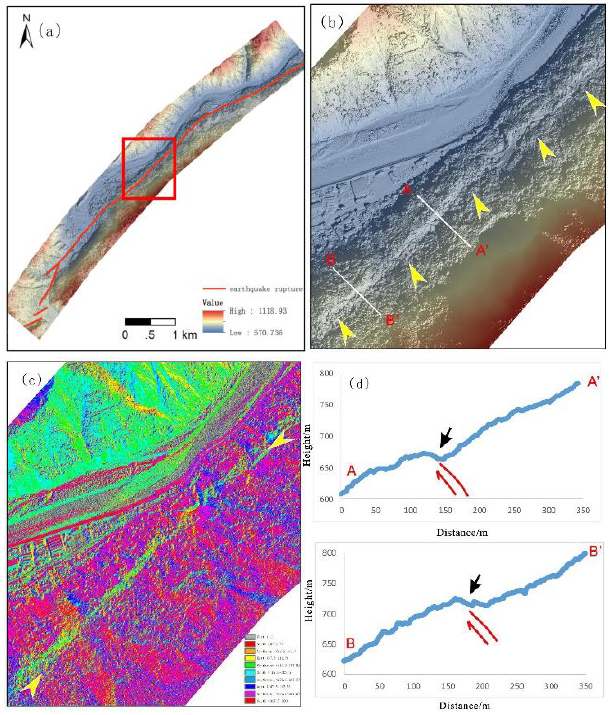
Figure 4. Beichuan topographic map and seismic surface rupture;(a) The shade-relief of the study area; (b)